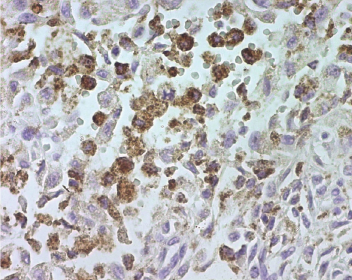
Figure 4: Tumor cells are focally positive for CD68 (immunohisto- chemistry ×